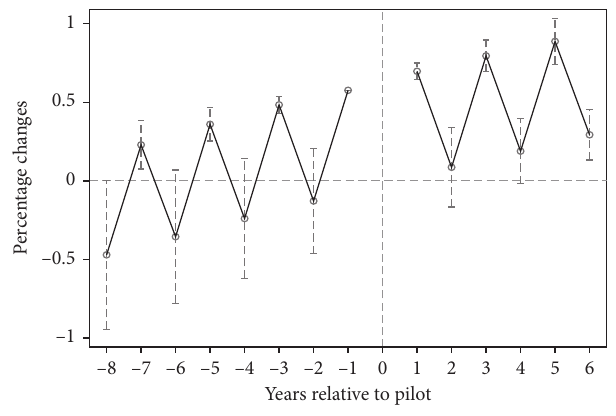
Figure 2: Parallel trend test